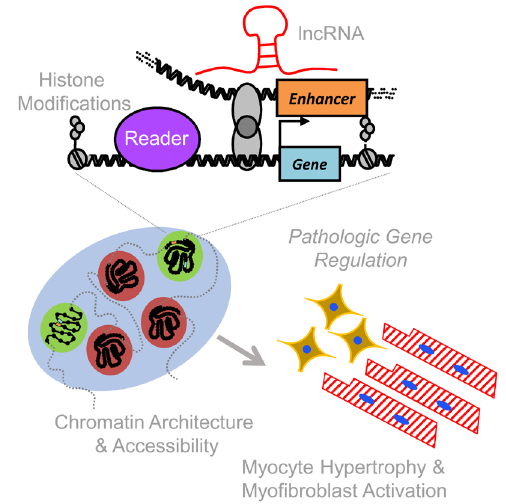
Figure 1. A model for integrating histone marks, long noncoding RNAs (lncRNAs), and chromatin architecture in heart failure. The epigenomic regulation of cardiac phenotype occurs at multiple interacting scales. Histone isoforms, post-translational